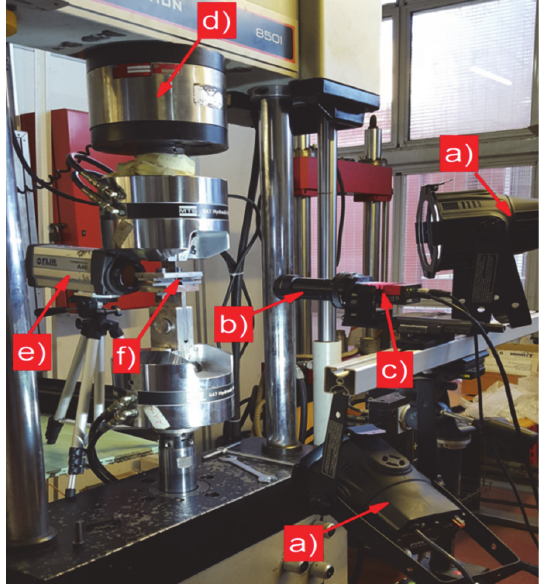
Figure 5: Gripping system of the testing machine. Figure 6: Experimental setup used for testing: a) light source, b) lens, c) camera, d) load cell, e) thermal-camera, f)